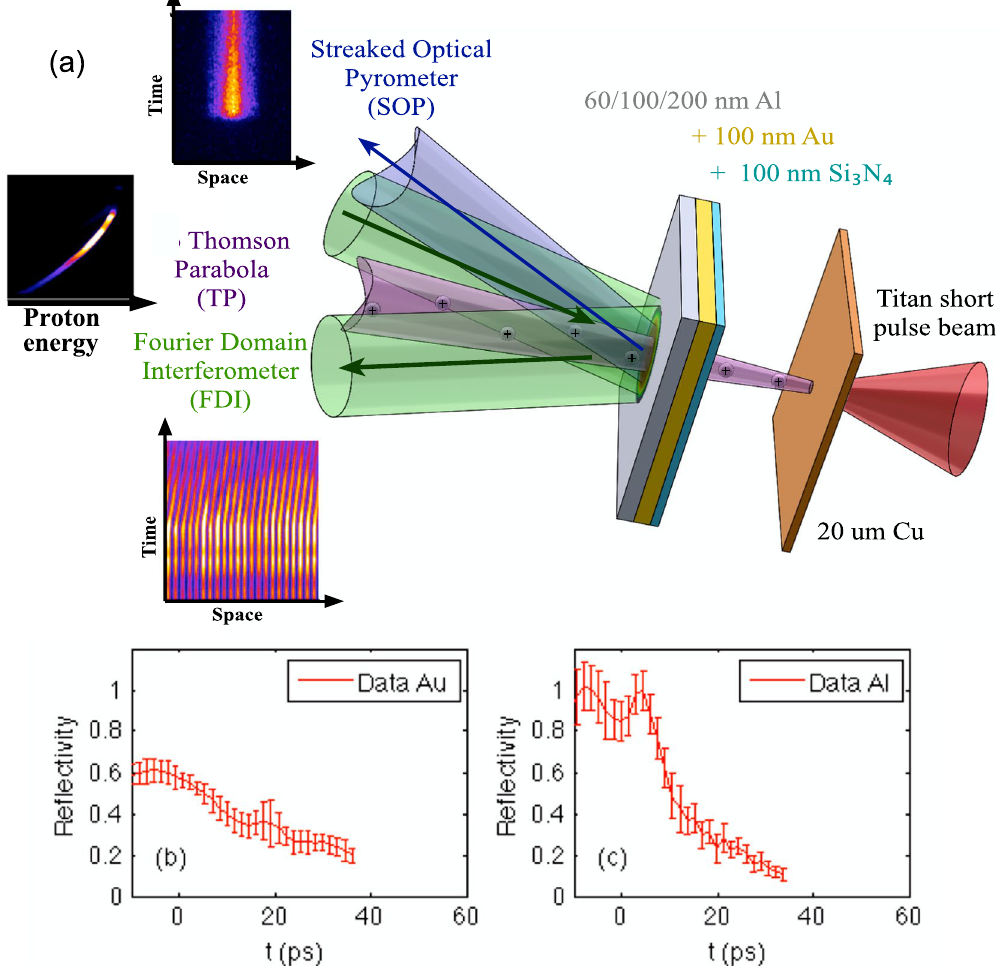
Figure 1. ( a ) Experimental setup for proton heating of multi-layer targets. Representative data of the SOP and FDI can be seen in the top and bottom left. The FDI beams were incident at 16 degrees from target normal in the horizontal plane and the SOP was measured at 16 degrees from target normal in the vertical plane. The plots are the measured reflectivity at 527 nm vs time for Au only ( b ) and Al targets ( c